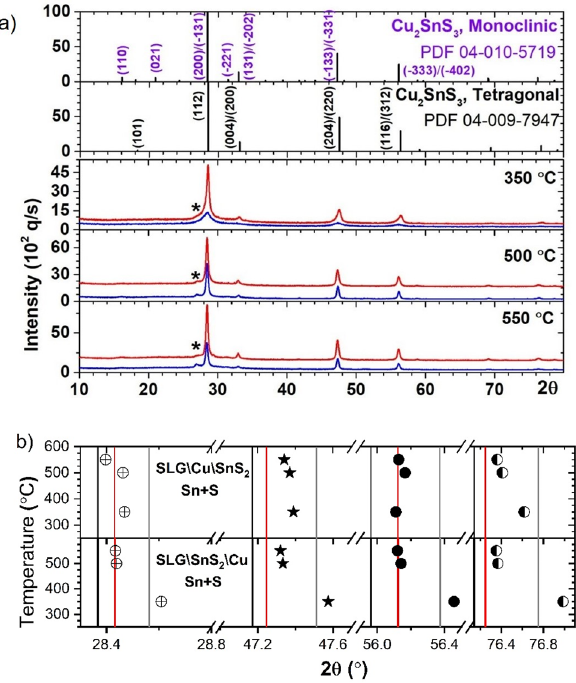
Figure 2. GIXRD analysis of the stacks annealed in sulfur and tin atmosphere at 350, 500 and 550 °C. ( a ) GIXRD patterns of the SLG\Cu\SnS 2 stack (blue) and the SLG\SnS 2 \Cu stack (red, shifted vertically for a better representation). The ICDD patterns of monoclinic (04-010-5719) and tetragonal (04-009-7947) CTS are also shown. Traces of crystalline CuS (00-006-0464) phase marked as “*” are present in all the samples. ( b ) The angular positions of the most intense CTS peaks in relation to the ICDD cards of tetragonal (04-009-7947) (gray: (112), (204)/(220), (116)/(312), (316)/(332)), cubic (04-002-6009) (black: (111), (220), (311), (331)) and monoclinic (04-010-5719) (red: (200)/(−131), (−133)/(−331), (−333)/(−402), (−135)/(−531))